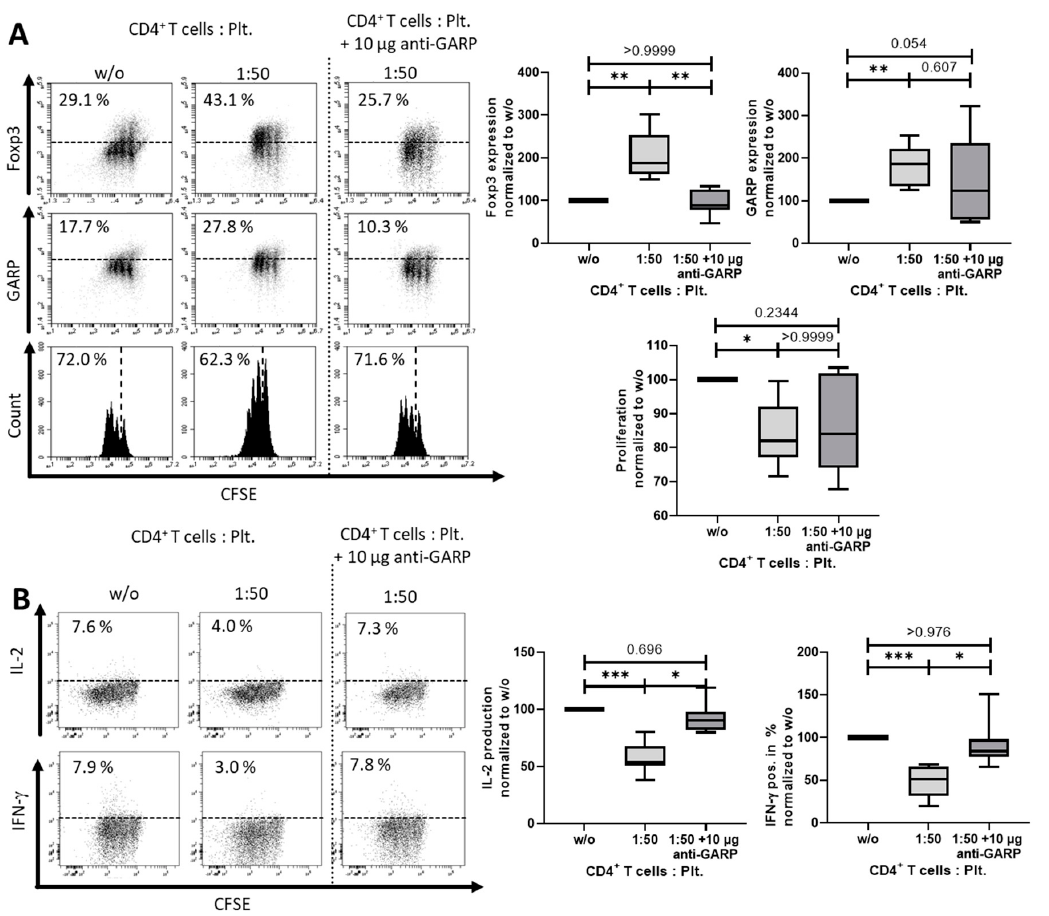
Figure 4. Platelets induced iTreg in a mainly GARP-dependent manner. ( A ) Blocking anti-GARP antibody inhibited platelet-induced e ff ects on FoxP3 and GARP expression, as well as proliferation. CFSE-labeled CD4 + CD25 − T cells were stimulated with 0.5 µ g / mL anti-CD3 mAb and 1.0 µ g / mL CD28 mAb with di ff erent ratios of platelets. In coculture, 10 µ g / mL blocking anti-GARP Ab was added at day 0, as indicated. Foxp3 and GARP expression and proliferation is shown on day 3 after stimulation. ( B ) Cytokine production is shown on day 6. The graphs show cells cultured in the presence of platelets normalized to CD4 + CD25 − T cells without platelets. For analysis, only live cells were included. Representative dot plots of eight independent experiments are shown ( n = 9, box and whiskers, medians ± min/max, * p < 0.05, ** p ≤ 0.01, *** p ≤ 0.001, and n.s. determined by one-way ANOVA).